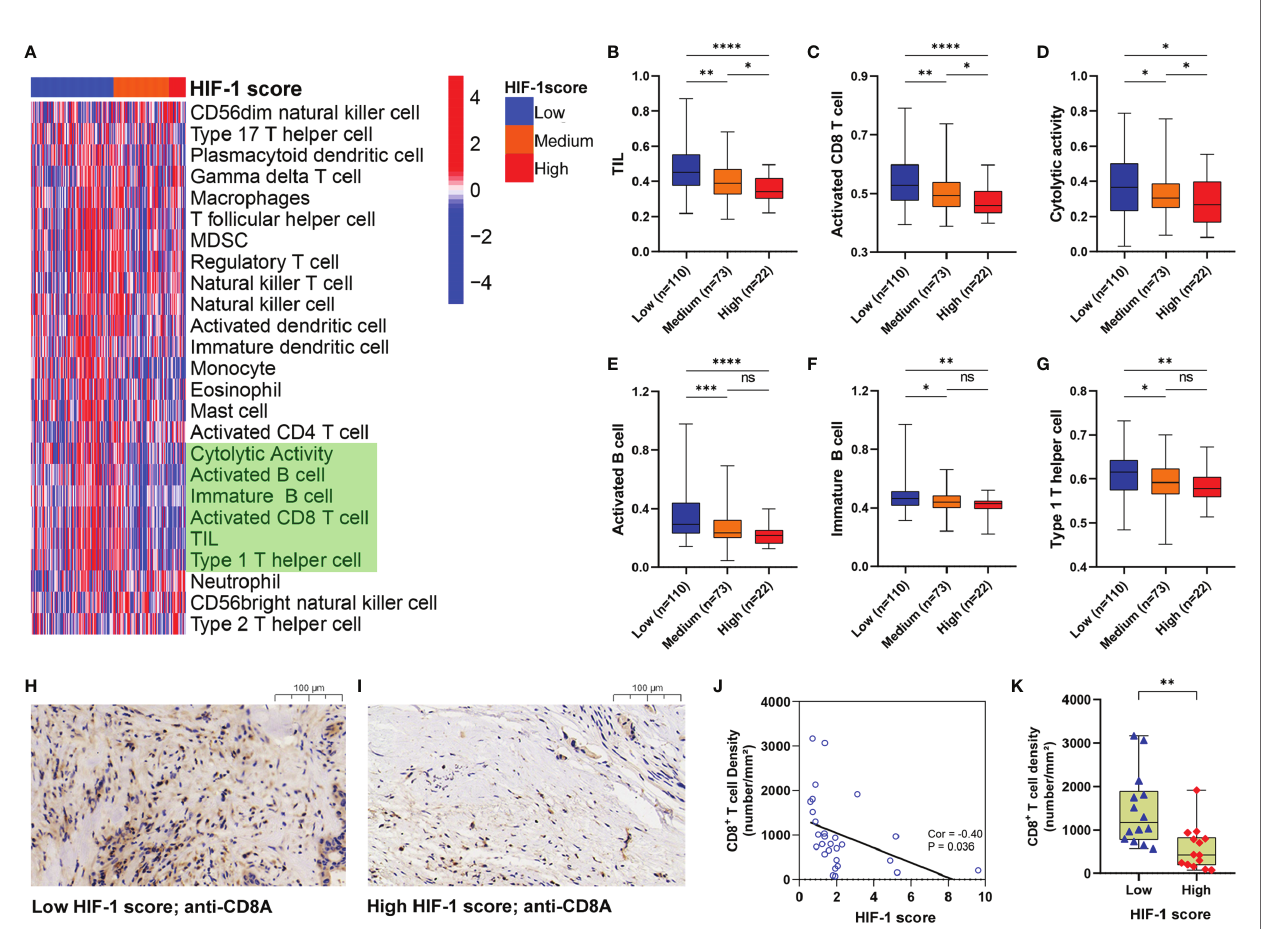
FIGURE 7 | Tumors with high HIF-1 score were associated with immunosuppressive phenotype. (A) Heatmap to show the 25 immune-related terms in the three HIF-1 score groups. (B – G) Differences of TIL, activated CD8 + T cell, cytolytic activity, activated B cell, immature B cell, and Type 1 T helper cell among the three HIF-1 score groups. (H) Representative image of CD8A immunostaining in low-HIF-1 score tumor. (I) Representative image of CD8A immunostaining in high-HIF-1 score tumor. (J) Negative association between the HIF-1 score and CD8 + T cell in fi ltration. (K) Tumors with high HIF-1 scores exhibited decreased CD8 + T cell in fi ltration compared with those with low HIF-1 scores. TIL, tumor-in fi ltrating lymphocytes. ns > 0.05; *P value < 0.05; **P value < 0.01;***P value < 0.001; ****P value <